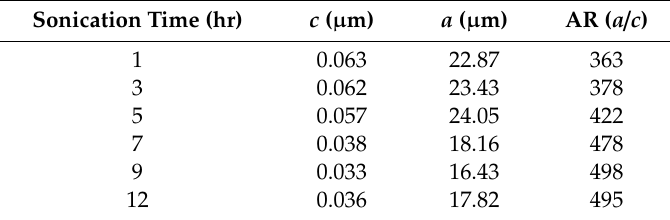
Table 8. a , c , AR values for sample M X2C3 ( d = 48.5 Å).